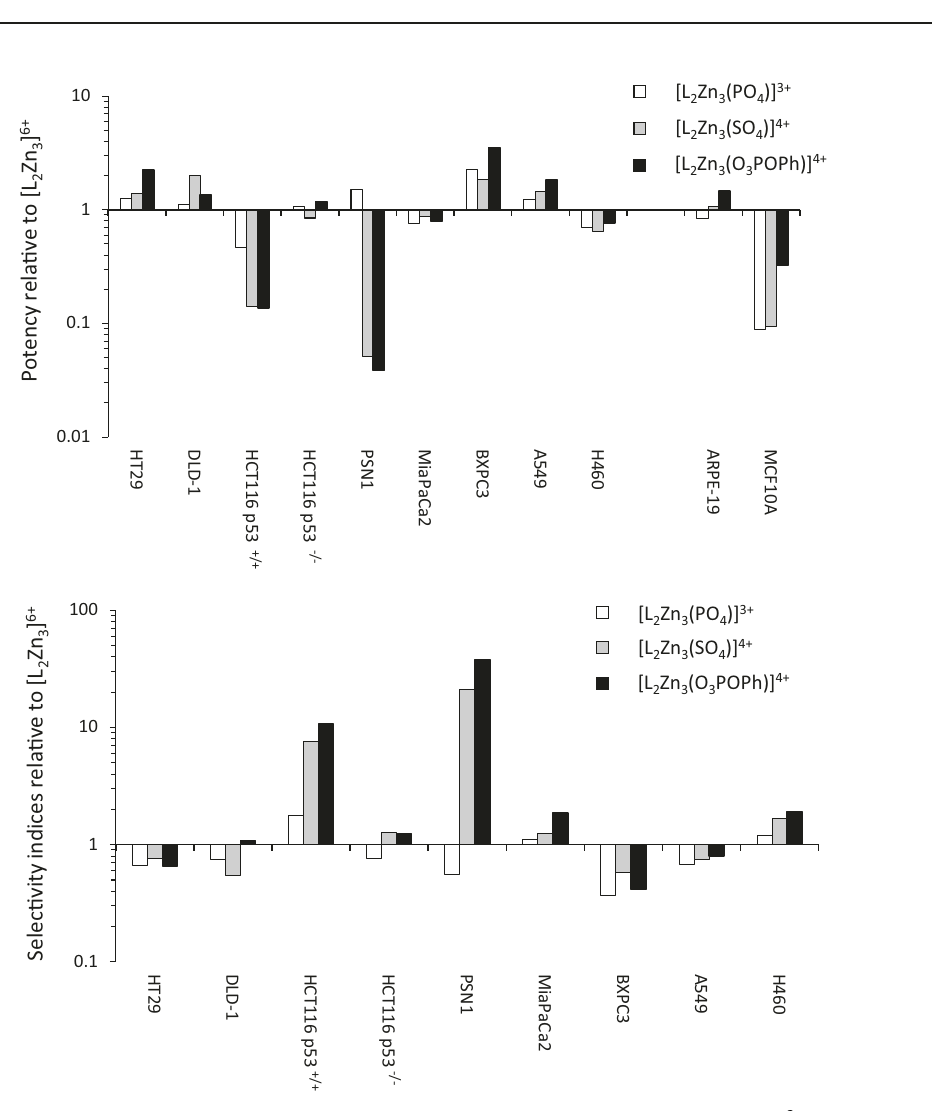
Fig. 5 Chemosensitivity response of a panel of human cancer and non-cancer cell lines to 96 h continuous exposure to self-assembling test compounds. a , b The potency of compounds tested against cancer (HT-29, DLD-1, HCT116 p53 + / + and p53 − / − , PSN1, MiaPaCa2, BxPC3, A549, H460 and GBM1) and non-cancer cells (ARPE-19, MCF10A and NP1). Each value represents the mean IC 50 ± SD from a minimum of three independent experiments. The selectivity index (SI) for [L 2 Cu 3 ] 6 + ( c ) and [L 2 Zn 3 ] 6 + ( d ) for the indicated cancer cell lines; SI is de fi ned as the mean IC 50 against the particular non-cancer cell line model divided by the mean IC 50 against the particular cancer cell line. SI values > 1 indicate that the test compound is more active against the particular cancer cell line than the corresponding non-cancer cells. As the SI value is calculated using the mean IC 50 values, experimental error is not included in these fi gures. e IC 50 values for the clinically approved platinates (cisplatin, oxaliplatin and carboplatin) and [L 2 Mn 3 ] 6 + ( n = a minimum of three independent experiments and each value represents the mean IC 50 ± SD from a minimum of three independent experiments) and f the corresponding SI results.